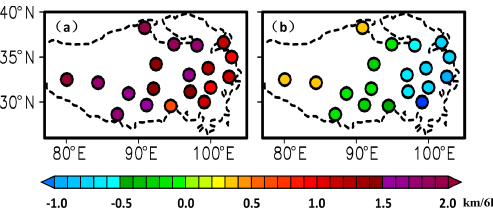
Figure 4. Spatial distribution of the ABLH growth rate from 08:00 to 14:00BJT (a) and from 14:00 to 20:00BJT (b) .